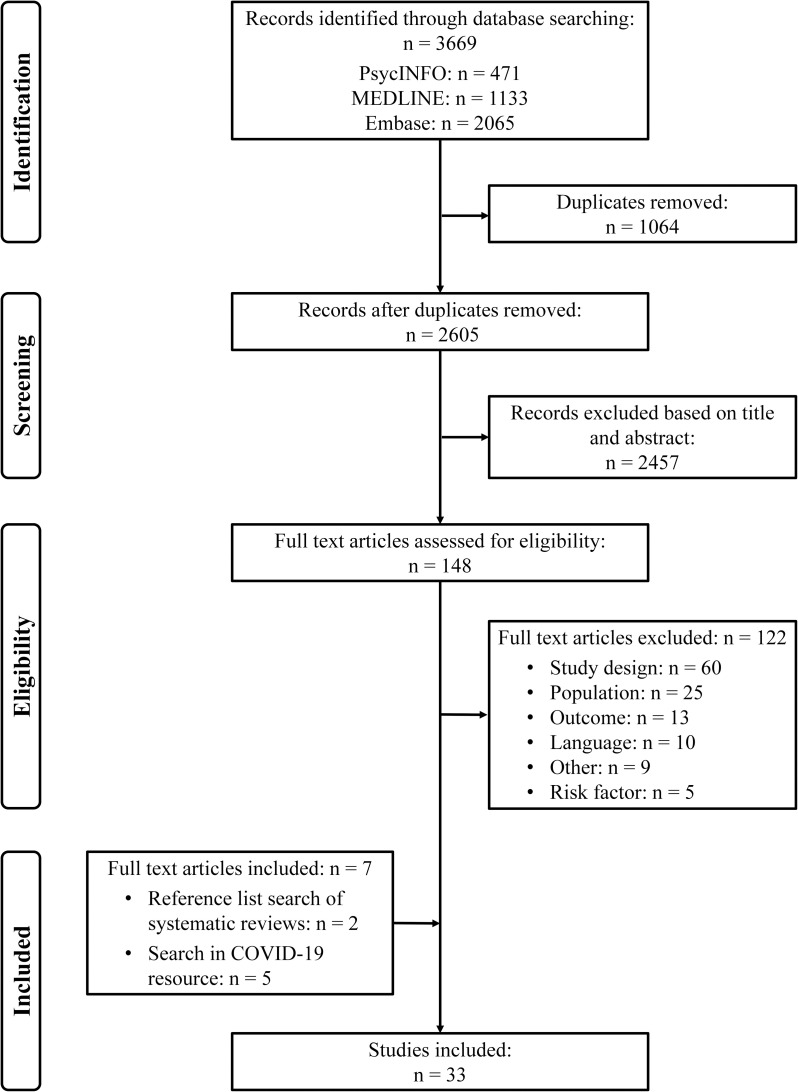
PRISMA flowchart for the selection of eligible studies.